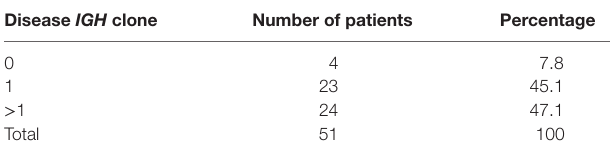
TaBle 1 | leukemic clones identification in 52 B-all